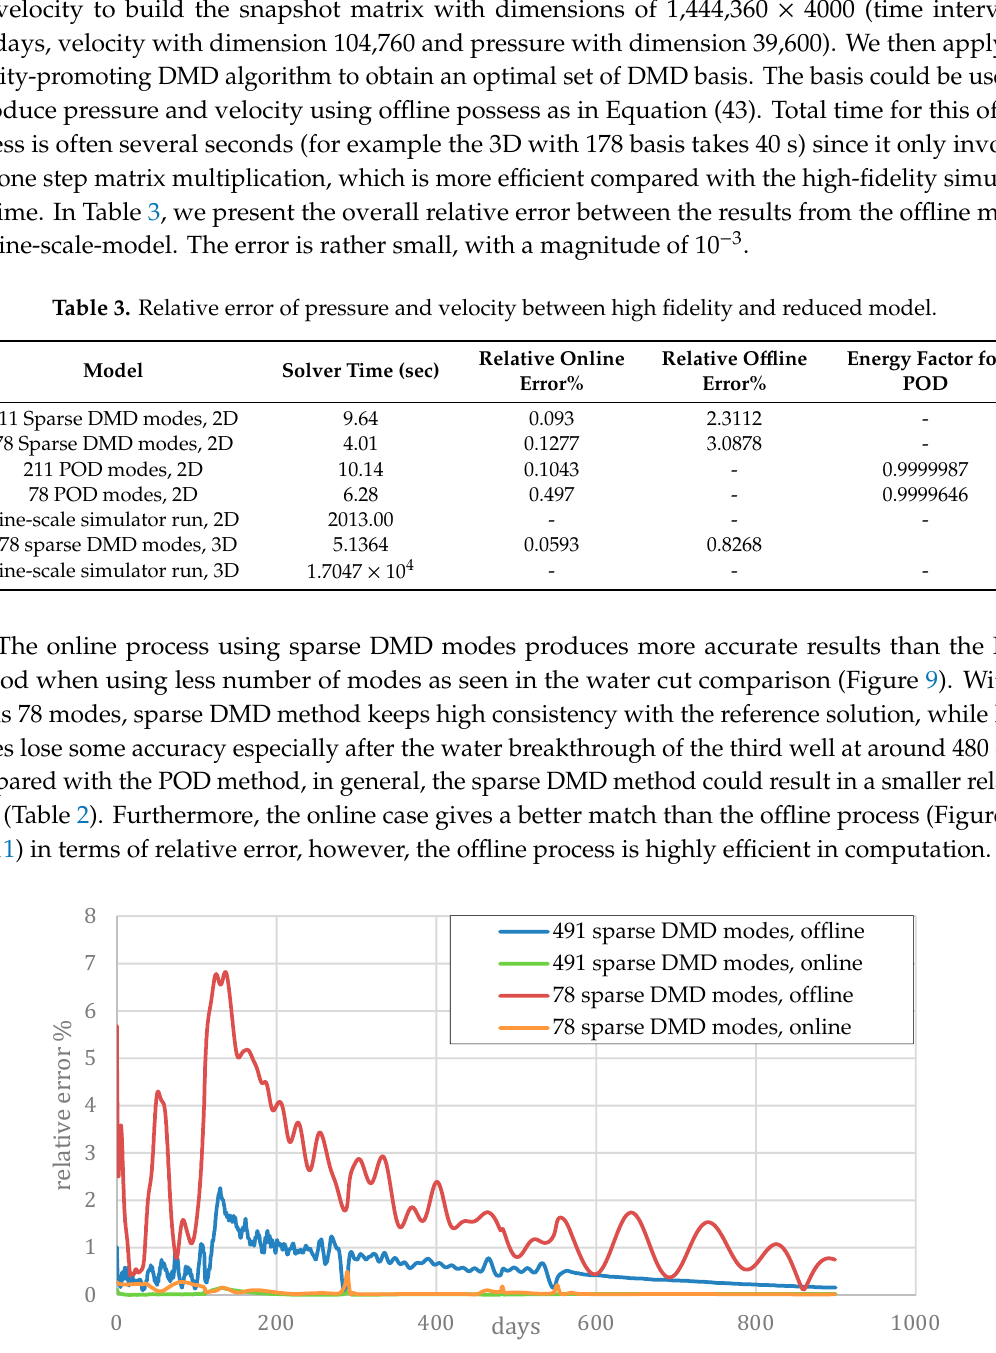
Figure 10. Relative error of pressure and velocity as the change of time in 2D reservoir.